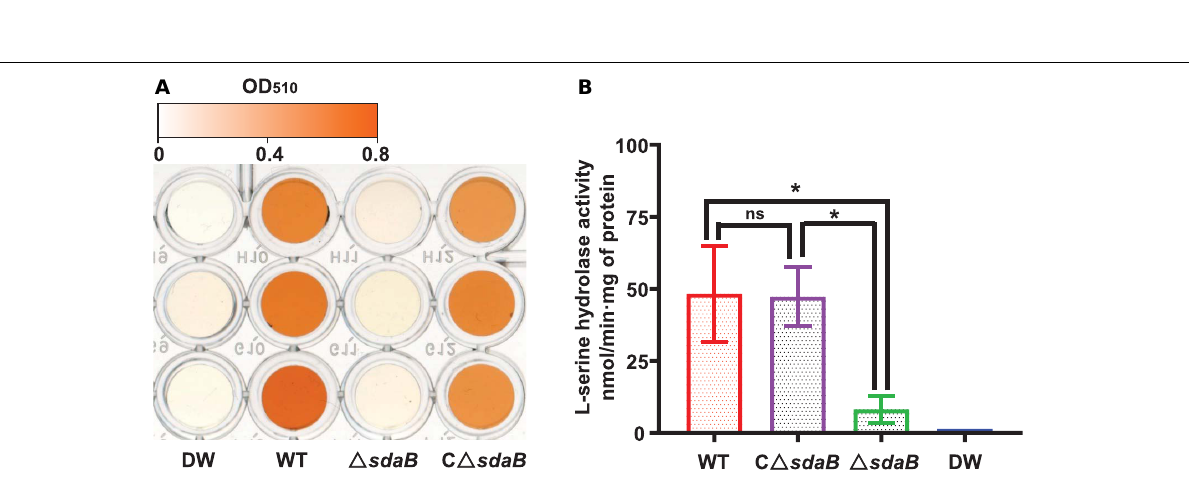
Frontiers in Microbiology |